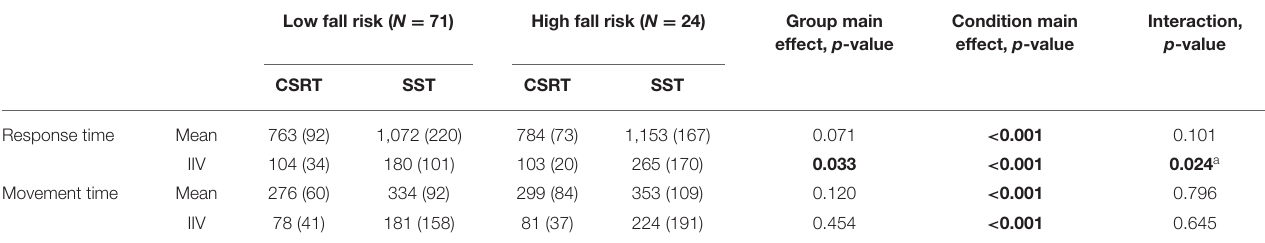
TABLE 3 | Stepping performance results by group for the choice stepping reaction time (CSRT) test and Stroop stepping test (SST). Low fall risk ( N = 71)